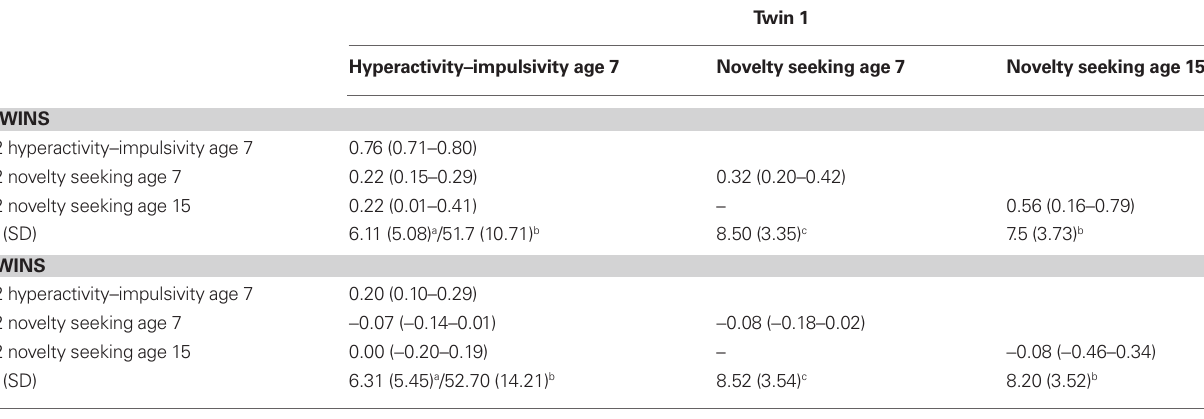
Table 1 | Maximum likelihood twin correlations (95% confidence intervals in brackets) and means (SD in brackets) for and across hyperactivity– impulsivity age 7, novelty seeking age 7, and novelty seeking age 15.